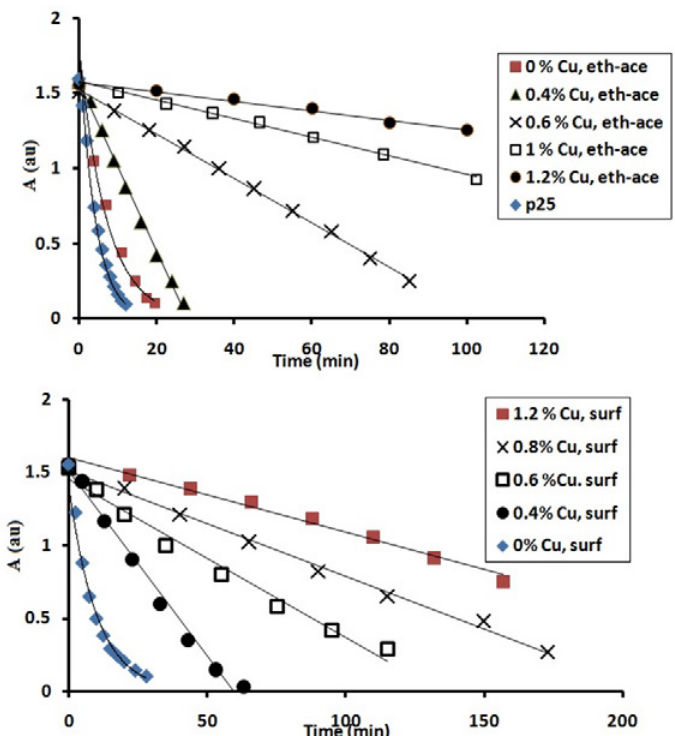
samples prepared in two different media. 2